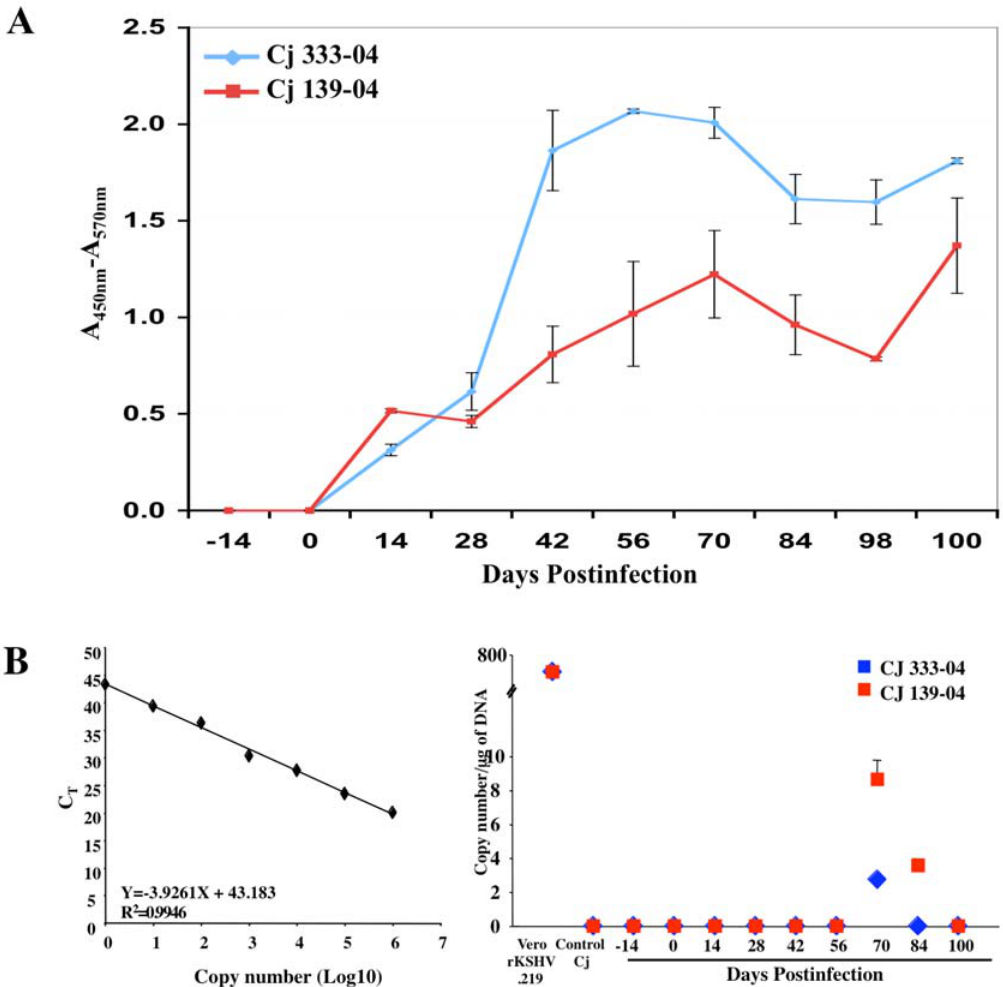
Figure 4. Persistent rKSHV.219 infection is reduced by FK506 treatment. ( A ) ELISA using the sera (1:100 dilution) of infected, FK506-treated common marmosets (Cj333-04 and Cj139-04) against the lysed recombinant virus. The results show the averages of two repeats and standard deviations. These assays were reproduced by two independent occasions. ( B ) Detection of KSHV DNA from FK506-treated, rKSHV.219-infected common marmosets Cj333-04 and Cj139-04. Genomic DNA (100 ng) purified from the PBMCs of FK506-treated marmosets Cj333-04 and Cj139-04 were used for real-time PCR reactions with LANA-specific primers. Genomic DNA from Vero.rKSHV.219 cells (P) was included as a control and the viral DNA copy number/ m g of DNA calculated using a standard curve with pcDNA3-LANA DNA. M, 100-bp DNA molecular markers. The results show the averages of two repeats and standard deviations. top tamarins ( Saguinus oedipus ) inoculated with human Epstein-Barr virus (EBV) develop diffuse malignant lymphomas resembling human reticulum cell or immunoblastic sarcomas [29,30]. Addi-